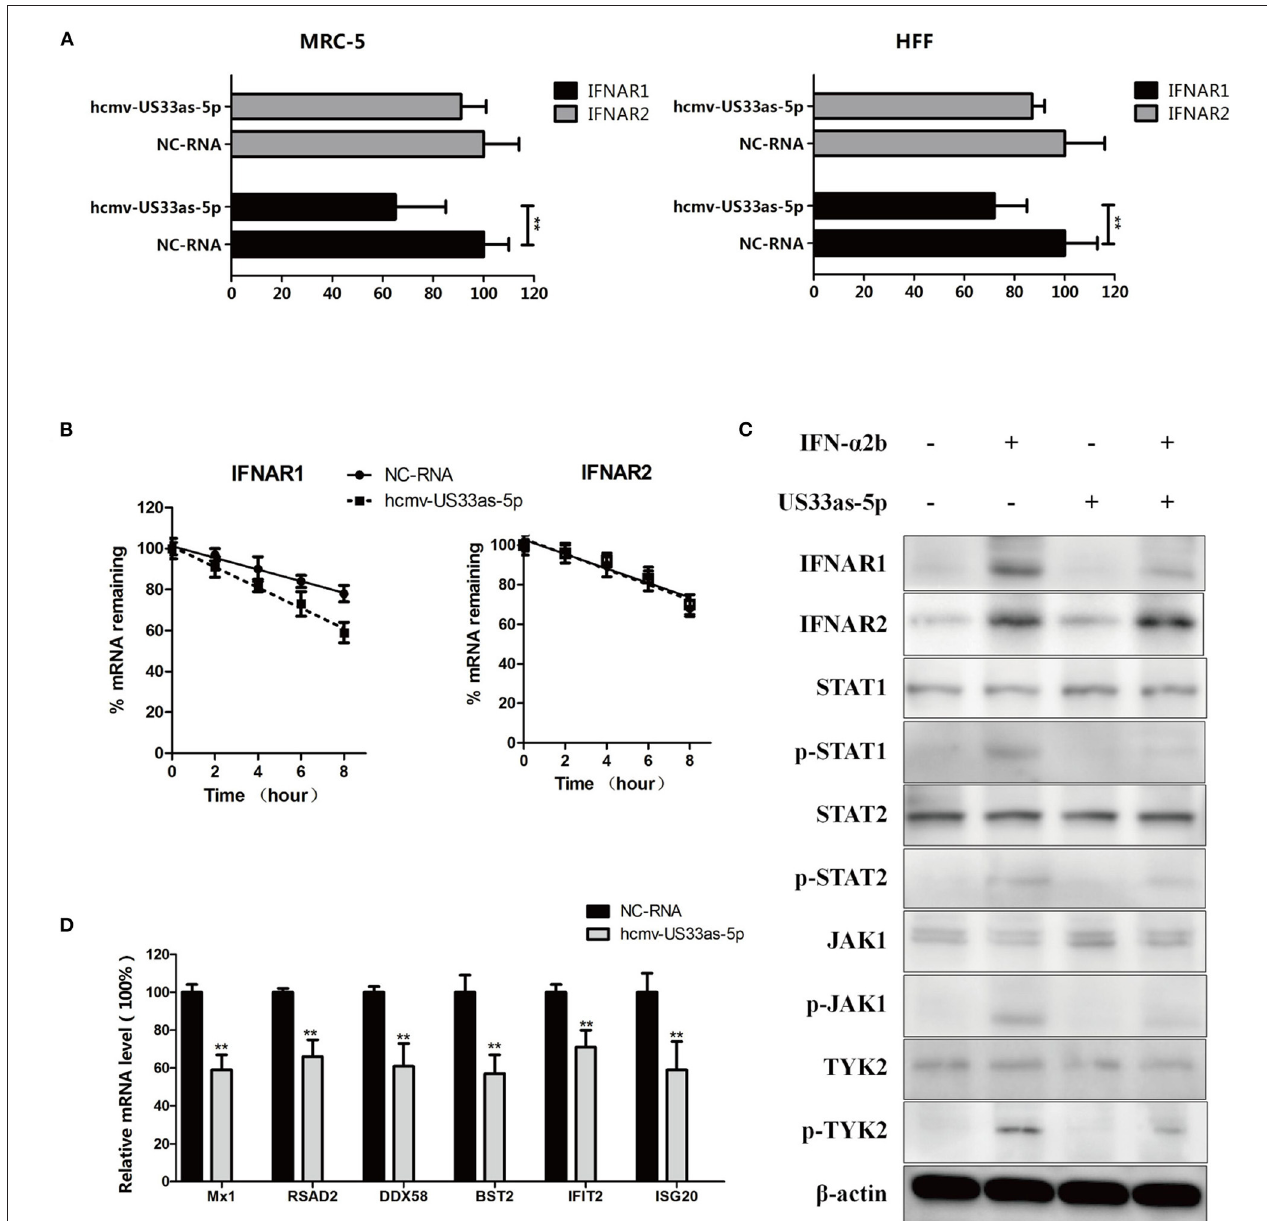
FIGURE 3 | hcmv-miR-US33as-5p downregulates IFNAR1 and Jak-STAT, limiting the release of ISGs. (A) MRC-5 and HFF cells were cultured in 24-well plates and transiently transfected with hcmv-US33as-5p mimics or a negative control RNA (NC-RNA) at a concentration of 100nM for 24h. The cells were treated with 10 µ g/mL CHX, followed by stimulation by 1,500 U/mL IFN α for 1h until harvest. The expression of IFNAR1 and IFNAR2 was determined by qPCR. (B) The mRNA stability of IFNAR1 and IFNAR2 in MRC-5 cells transfected with US33as-5p mimics or NC-RNA and incubated with actinomycin D to inhibit transcription is presented as the amount of mRNA detected at a given time relative to that at 0h, which was set as 100%. (C) Immunoblotting of lysates from MRC-5 cells underwent treatment similar to that described in Figure 3A and prolonged incubation with 1,500 U/mL IFN- α for 6h. was performed. Blots were probed for IFNAR1, IFNAR2, STAT1, STAT2, Jak1, Tyk2 and their phosphorylated forms. β -Actin was run as a loading control. (D) The expression of multiple ISGs (Mx1, RSAD2, DDX58, BST2, IFIT2, and ISG20) in MRC-5 cells was determined by qPCR. The RNA harvested from MRC-5 cells underwent treatment similar to that described in Figure 3C . GAPDH was amplified as a loading control. The assays were performed in triplicate wells, and data were collected from two different experiments and are represented as the means ± SDs; ** p < 0.05. in medium for another 5 days ( Figure 7A ). Expression of THP-1 cells were infected with WT or 1 miRNA HCMV and the IE gene (UL122) was not detected until 9 days post- maintained for 10 days in culture medium. Then, the THP-1 cells infection (dpi) in THP-1 cells and detected after 1 day of were stimulated with TPA at 50 ng/mL and further maintained